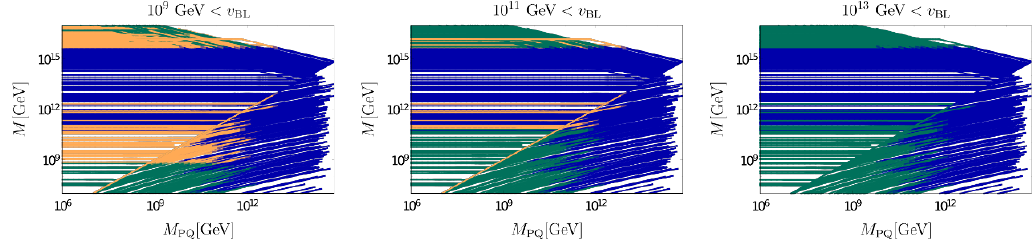
Figure 7 . Intermediate scales M PQ and M BL and GUT-scale M U for di(cid:11)erent threshold corrections in Model 2.1. Refer to (cid:12)gure 5 for clearer view of the di(cid:11)erent scales. The curves in blue are excluded by gauge-mediated proton decay limits, the curves in green by the limit on the B-L breaking scale.